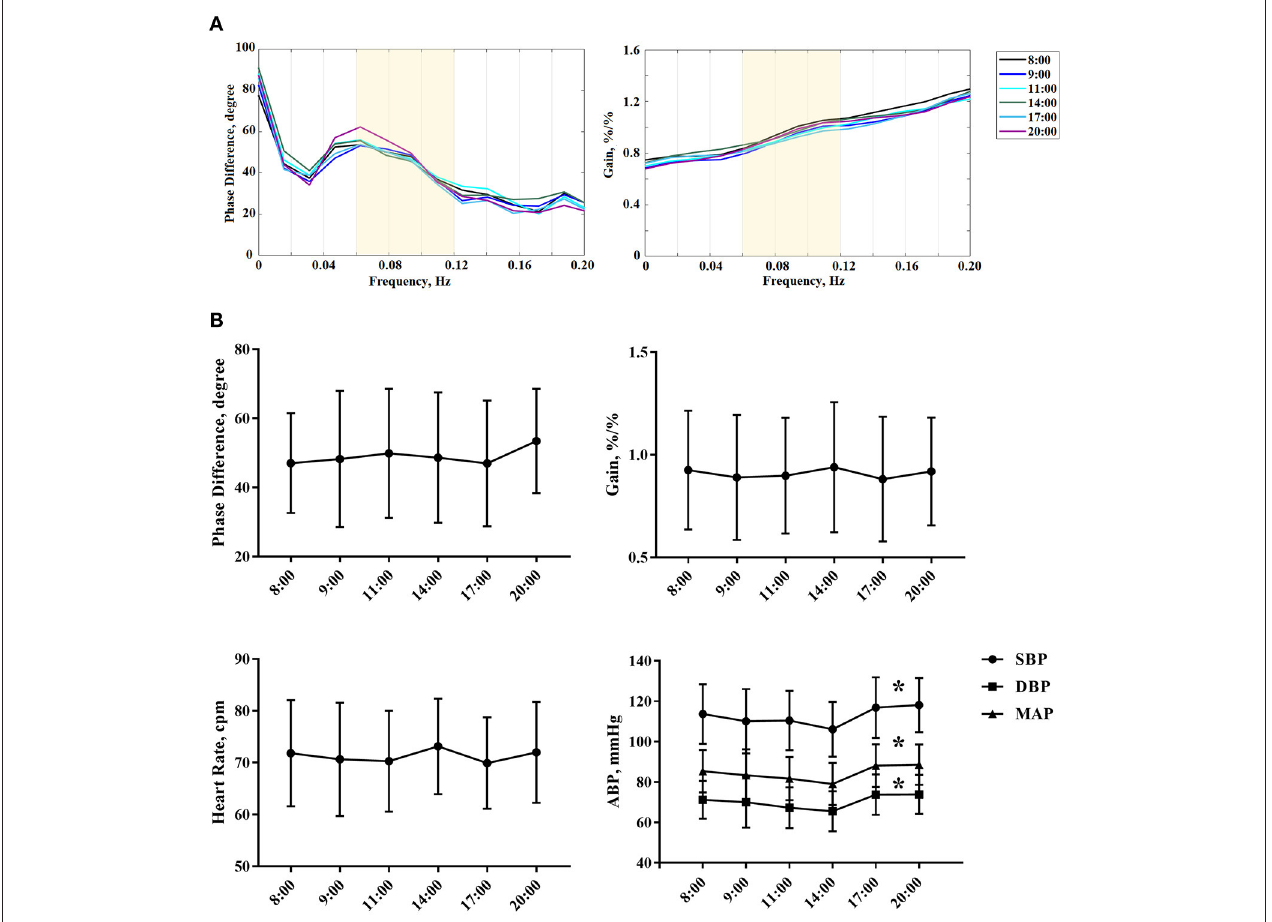
FIGURE 1 | (A) The autoregulatory parameter (phase difference and gain) derived from the transfer function analysis and estimated over a range (0.06–0.12Hz, the yellow area) at 8:00, 9:00, 11:00, 14:00 ,17:00, and 20:00. Each colored line denotes the averaged PD or gain estimated from all subjects at one particular time point that we collected the data. (B) Statistical analysis of serial dCA, arterial blood pressure, and heart rate of serial measurements. The solid point represents means, and the whiskers denote standard deviation. * P < 0.05 for comparison of different time points by repeated measurement analysis of variance. HR, indicates heart rate; cpm, counts per minutes; SBP, systolic blood pressure; DBP, diastolic blood pressure; MAP, mean arterial